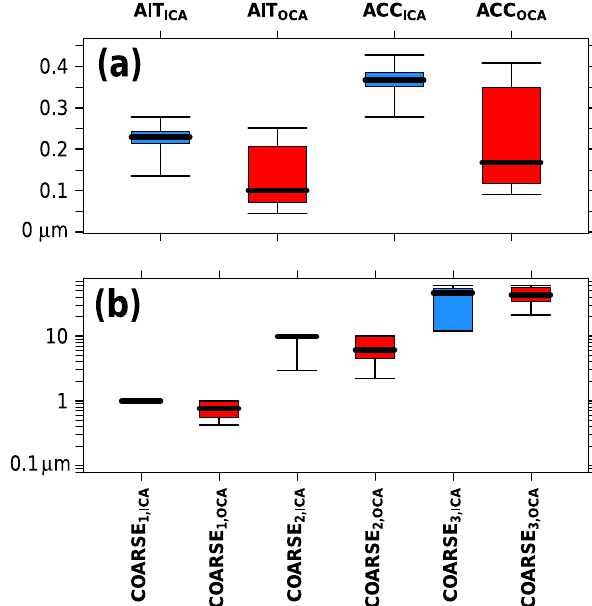
Figure D1. Box plots of (a) aerosol number density (cm − 3 ) and (b) dry (red) and wet (blue) aerosol diameters (µm) for AIT and ACC; box plots of (c) aerosol number density (cm − 3 ) and (d) dry (red) and wet (blue) aerosol diameters (µm) for COARSE split into the three COSMO-ART sea salt modes as median in the lowest 1500ma.g.l. over the Ivory Coast (7.5–3 ◦ W, 4–10 ◦ N) on 3 July, 06:00UTC. The whiskers span the data from percentile 2.5 to 97.5 (95% of the data). Data outside of this range are not shown. Note the different unit in (c) (conversion factor is 10 6 ) and the loga- rithmic scale in (d) . The absolute value of the number density of COARSE 3 is below 1.3m − 3 and is therefore not shown in (c) .